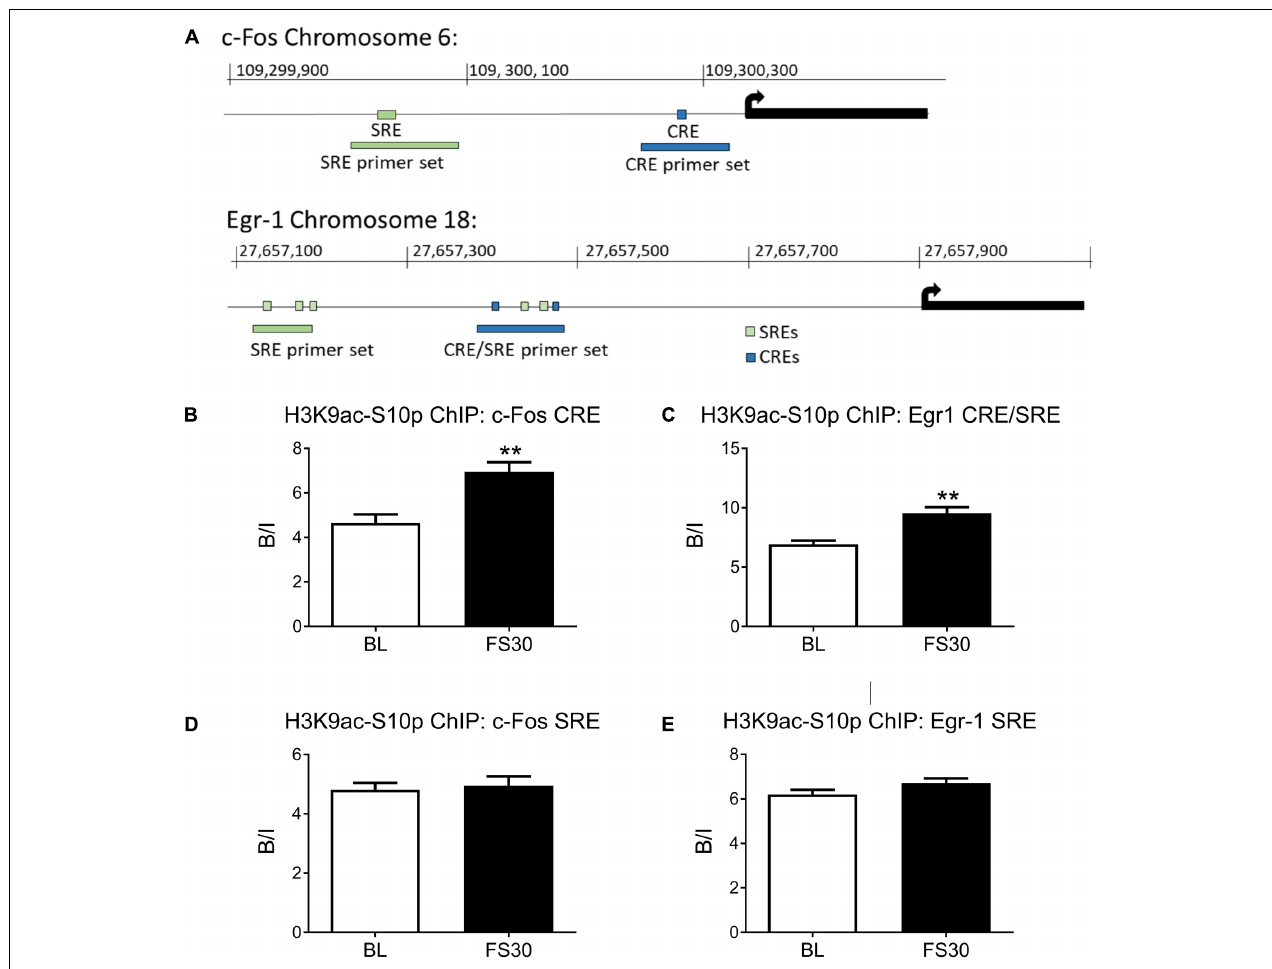
FIGURE 2 | Histone H3 phospho-acetylation in the promoter regions of c-Fos and Egr-1 . Rats were killed either under baseline conditions or 30 min after the start of FC (15 min in 25 ◦ C water). Chromatin immuno-precipitation was carried out on whole hippocampal tissue, using an antibody against H3K9ac-S10p. Primers for qPCR were designed to cover Serum Responsive Elements (SREs) and cAMP Responsive Elements (CREs) within the c-Fos and Egr-1 promoters. The location of the SREs, the CREs and the primers in the promoter regions of c-Fos and Egr-1 are shown in (A) . The graphs show enrichment of H3K9ac-S10p at (B) the c-Fos promoter CRE, (C) the Egr-1 promoter region containing both CREs and SREs, (D) the c-Fos promoter SRE, (E) the Egr-1 promoter region containing SREs. The level of enrichment for each group was calculated by dividing the quantity of target DNA in the H3K9ac-S10p-bound fraction by the quantity of DNA in the input fraction (ratio bound over input, B/I, mean ± SEM, n = 3). Statistical analysis: Student’s unpaired t -test; (B) t = 4.04, p = 0.0068, (C) t = 4.52, p = 0.004, (D) t = 0.37, p = 0.723, (E) t = 1.66, p = 0.148. ∗∗ p < 0.01 significantly different from